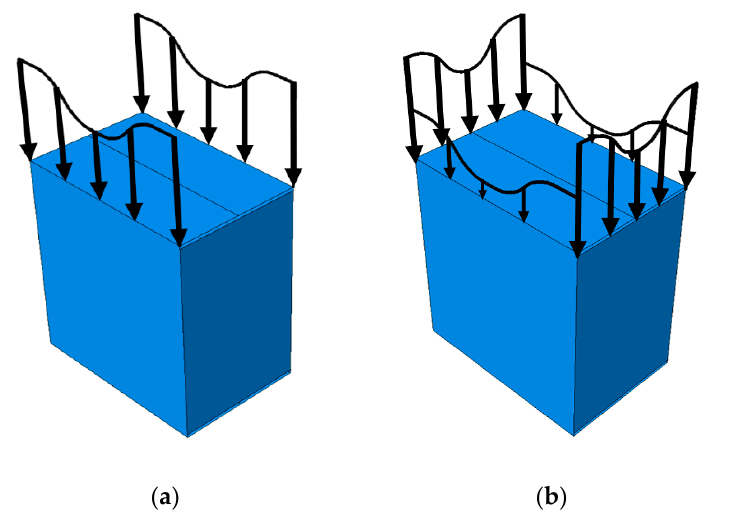
Figure 2. Sequence of loading of the package vertical walls: ( a ) edges loaded in the first step; ( b ) edges loaded in the second step.